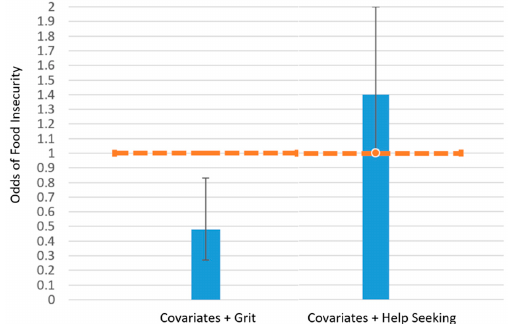
Figure 1. Grit, but not help-seeking, was inversely associated with the likelihood of being food insecure among rural Illinois veterans ≥ 18 years recruited from five food pantries from March 2021 to November 2021. (Logistic regression models with imputed data were used and adjusted by age and sex; n = 162 for food security, n = 170 for grit, and n = 164 for help-seeking were included for analysis). Orange dashed line indicates an odds ratio of 1 as reference; orange box highlights significant re- sults. Lastly, the regression model results between resource use with grit and help-seeking, respectively, are presented in Table 4. Neither grit nor help-seeking were associated with resource use. Similarly, modeling with the original data without imputation did not gen- erate significant results. Table 4. Grit and help-seeking were not associated with resource use among rural Illinois veterans ≥ 18 years recruited from five food pantries from March 2021 to November 2021 1 . Variable Estimates ± SE Covariates + Grit Covariates + Help-seeking Resource use (0–6 programs)